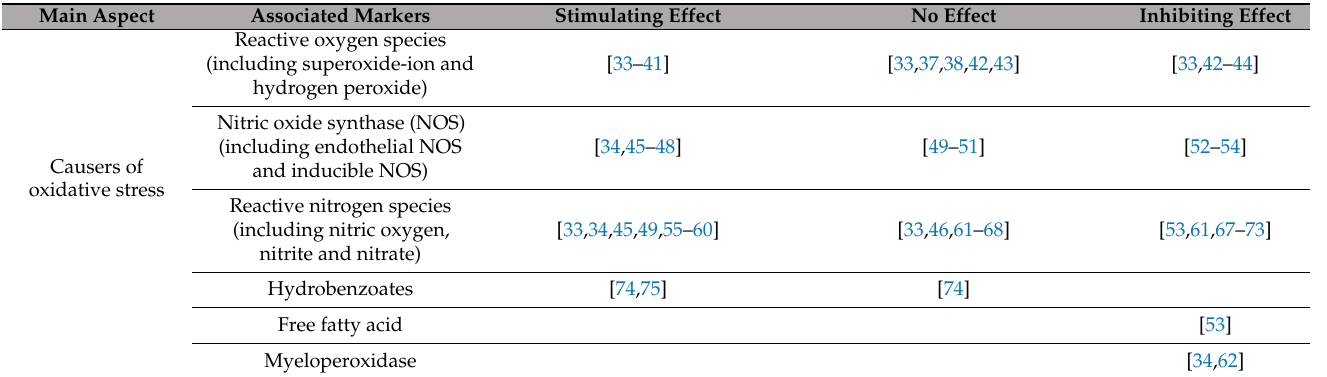
Figure 1. PRISMA Flow Diagram of the selection progress. Table 1. The effect of HBOT on oxidative stress markers.